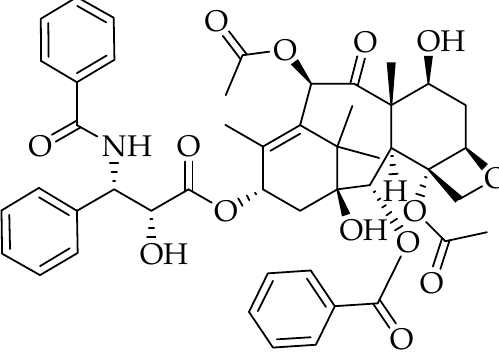
Figure 11. The chemical structure of paclitaxel.